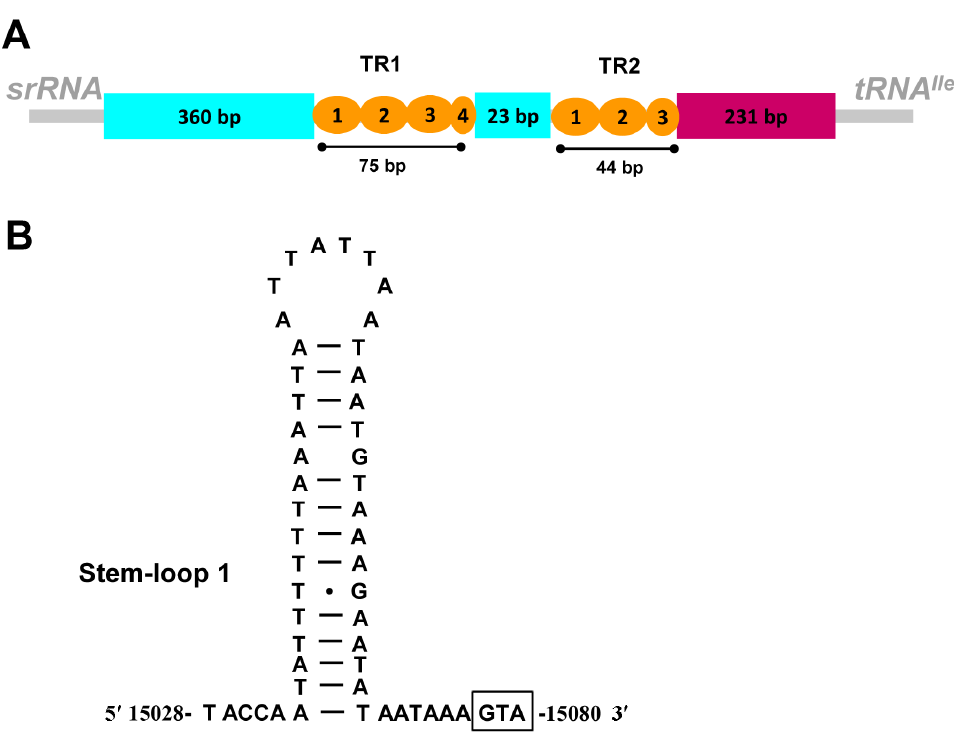
Figure 3. Control region of the M. flexura mitogenome. ( A ) Structure elements found in the control region of M. flexura . ( B ) Putative stem-loop structures found in the control region of M. flexura . One stem-loop (SL1, position: 15,028 bp–15,080 bp) structure is predicted in the con- trol region (Figure 3B). The proposed SL structure with a 3′ flanking “G(A)nT” motif is not detected in SL1, but it is modified as “GTA”. The stem-loop structure in the control region is identified in many insects and it is thought to be the site of the initiation of sec- ondary strand synthesis in Drosophila [48]. In addition, one microsatellite sequence (posi- tion: 15,376 bp–15,391 bp), (AT)8, is detected in the control region. Similar to other stone- flies mitogenomes [18,40,49], several poly-N stretch (≥ 7 bp) were also found near to the tRNA Ile , such as poly-T (9 bp, position: 15,668 bp–15,676 bp) and poly-A (9 bp, position: 15,574 bp–15,582 bp). Poly-T stretch is considered to be essential for the initiation of rep- lication in insects [50]. 3.5. Phylogenetic Relationships In the present study, concatenated nucleotide sequences of 13 PCGs from 17 nemourid mitogenomes were used to reconstruct phylogenetic relationships by the BI and ML methods. Two methods generated the same tree topologies (Figure 4).